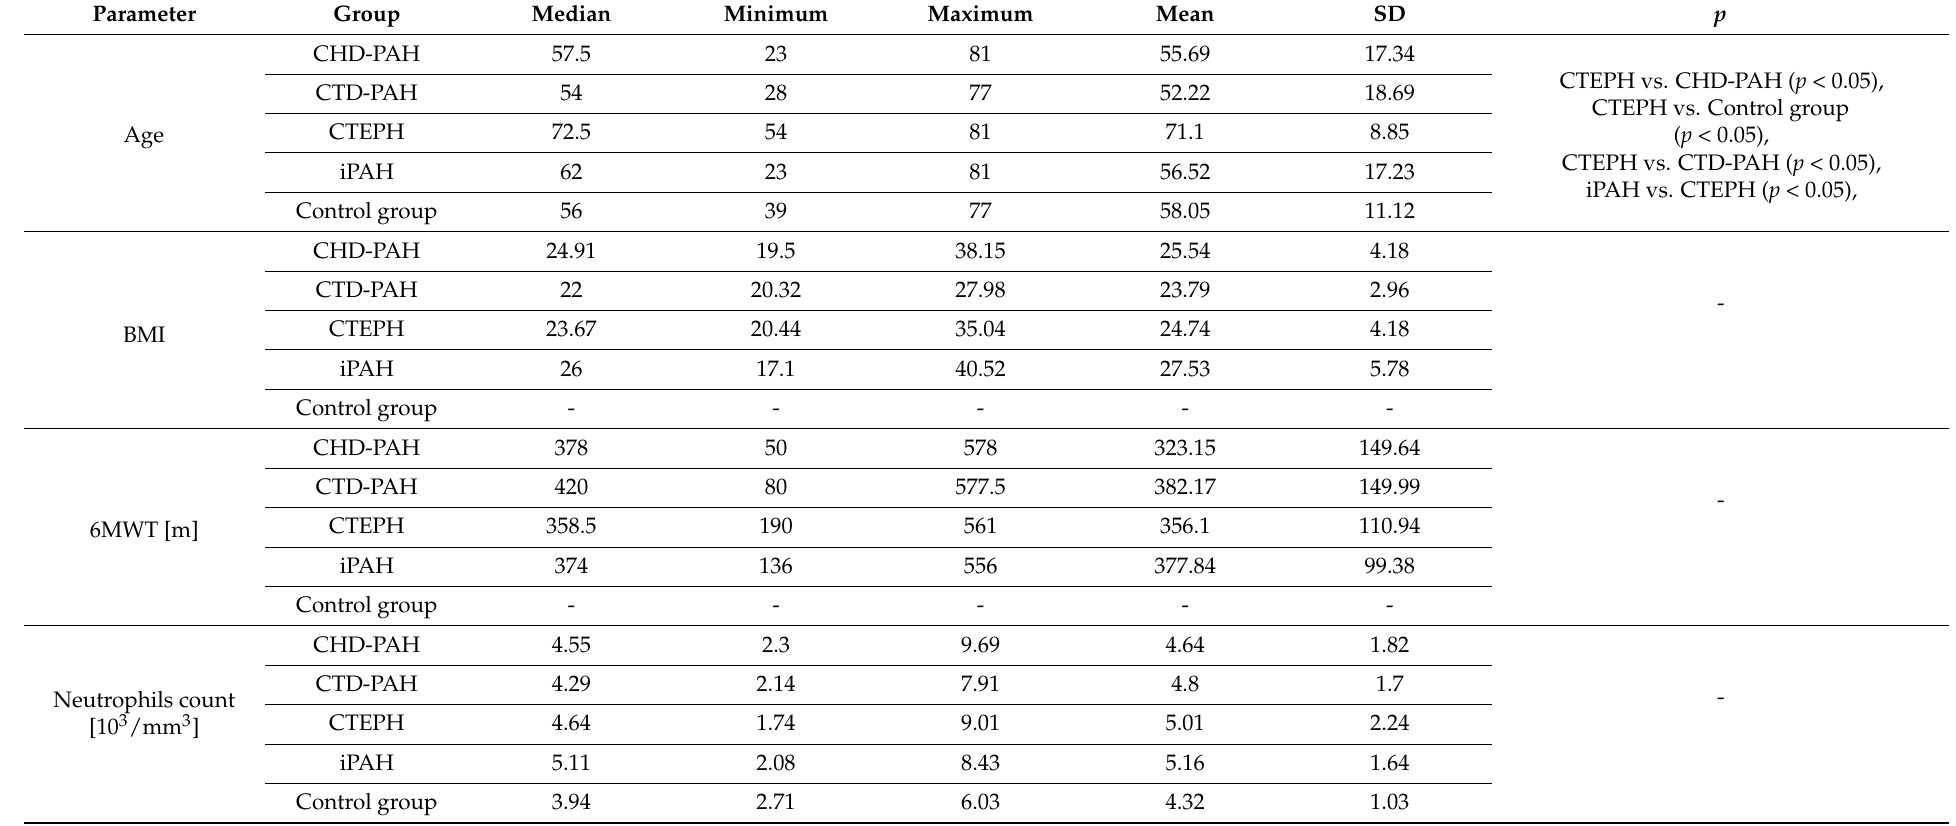
Table 2. Basic clinical and laboratory parameters characterizing patients with selected types of PAH and persons from the control